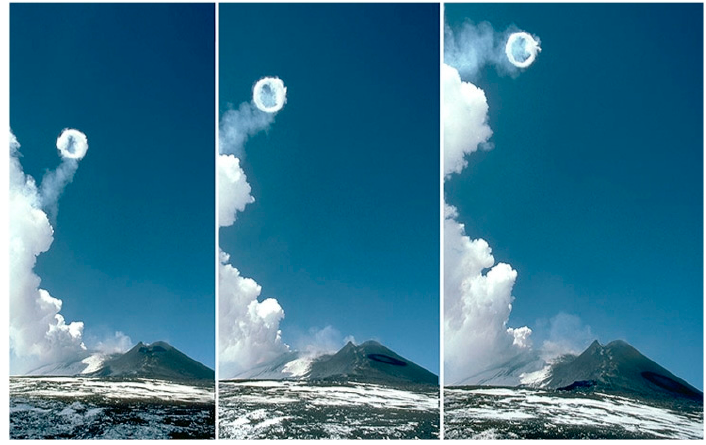
Figure 3. Smoke rings on the Etna volcano in Italy.